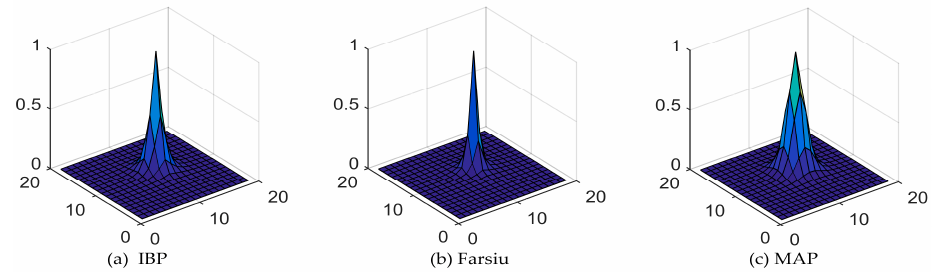
Figure 9. The PSFs between the upsampled reference image and the reconstructed HR images of the hilly area.